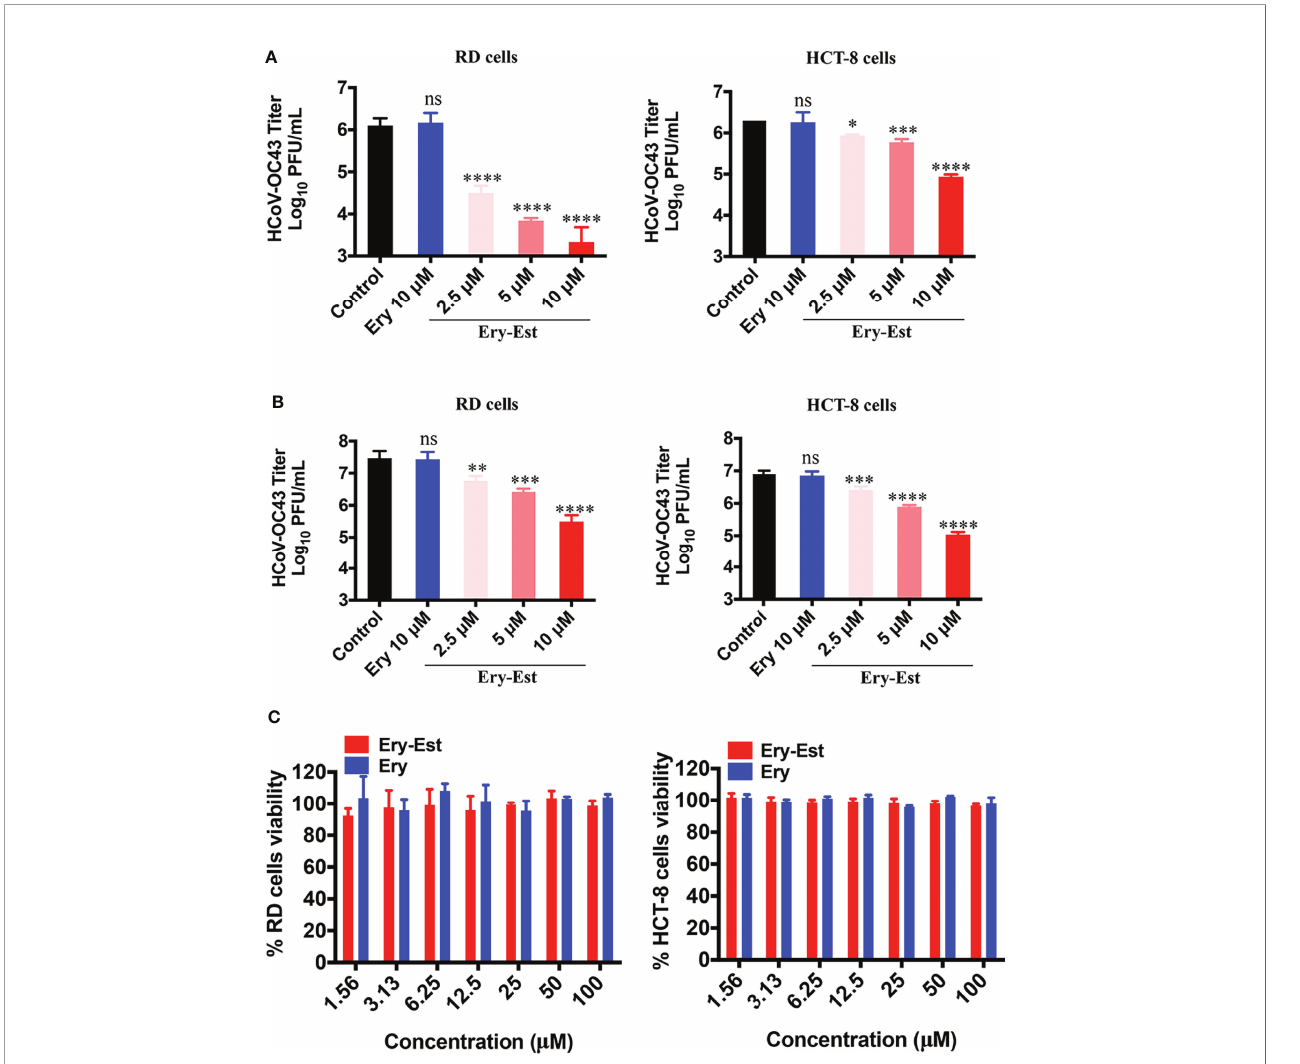
FIGURE 2 | Ery-Est reduced HCoV-OC43 titers in supernatants of infected RD and HCT-8 cells. (A) The inhibitory effect of Ery-Est on supernatant titers at an MOI of 0.1. (B) The inhibitory effect of Ery-Est on supernatant titers at an MOI of 1. (C) Ery-Est showed no cytotoxic to RD cells and HCT-8 cells. Each experiment was performed in triplicate, and the data were presented as means ± SD. ns, not signi fi cant; * p < 0.05; ** p < 0.01; *** p < 0.001; **** p <